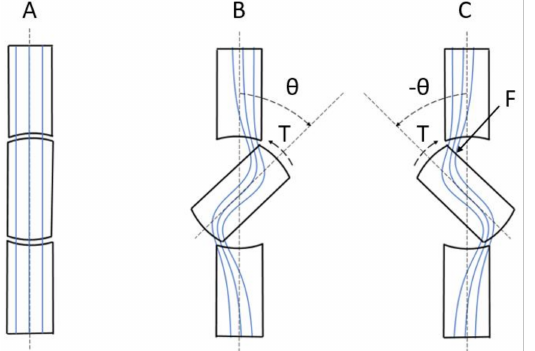
Figure 2. A segment of the magnetic circuit shown in Figure 1, consisting of the rotor and a small part of the stator. ( A ) The rotor and stator are aligned. ( B ) The rotor is turned to an angle θ and then released. ( C ) The rotor is forced to an angle − θ . The blue lines represent the magnetic flux lines. Positive rotation direction is